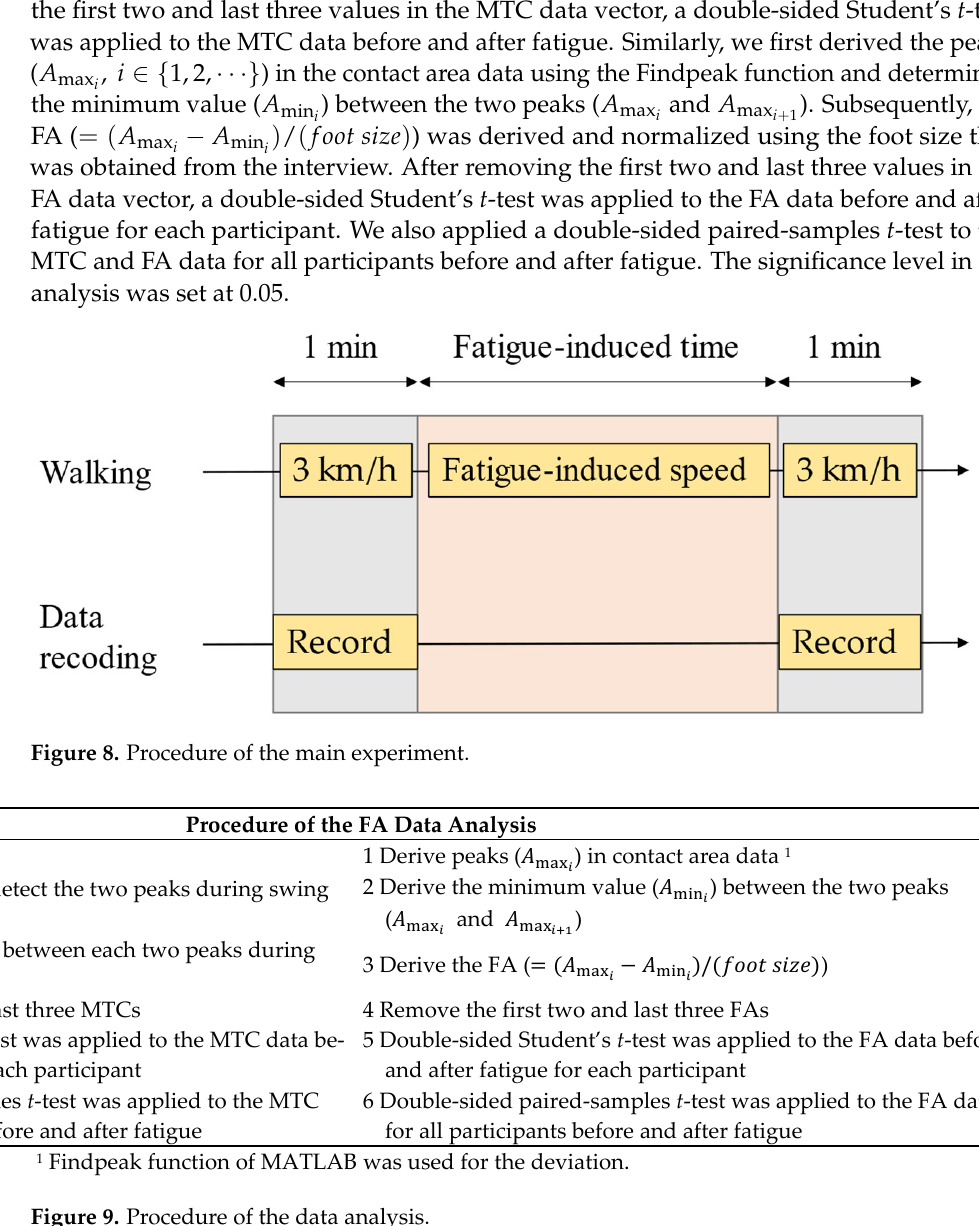
Figure 8. Procedure of the main experiment.